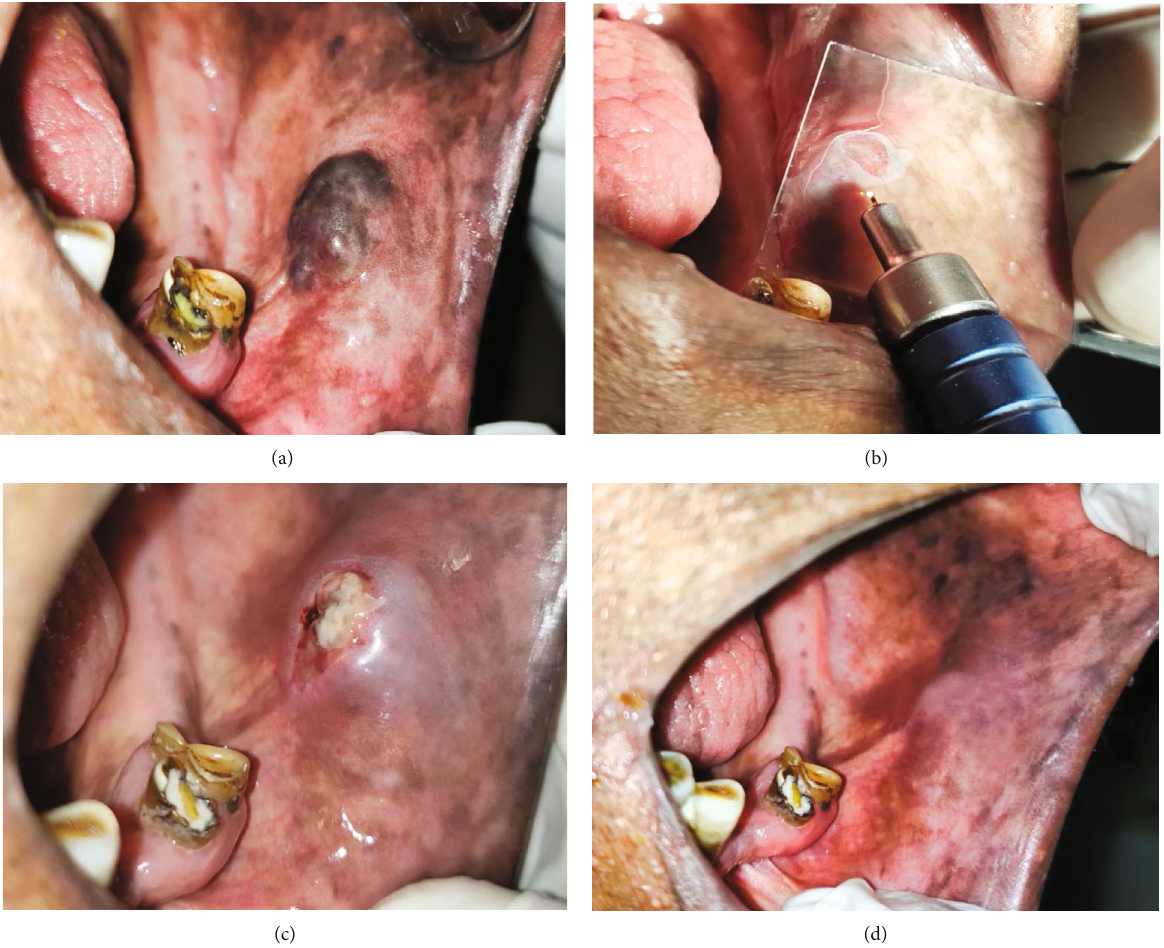
Figure 3: Treatment of a vascular malformation with diode laser by photocoagulation of the lesion (noncontact mode, 2 watt, 980 nm Indilase). (a) Presence of vascular malformation. (b) Laser exposure is done in noncontact mode 2-3 mm away from the lesion. We can use glass slide to avoid accidental exposure Just after laser procedure, presence of blanching is the indicator of photocoagulation. (c) After 3 days, ulcer is formed in place of vascular malformation. (d) Healing completed with complete disappearance of